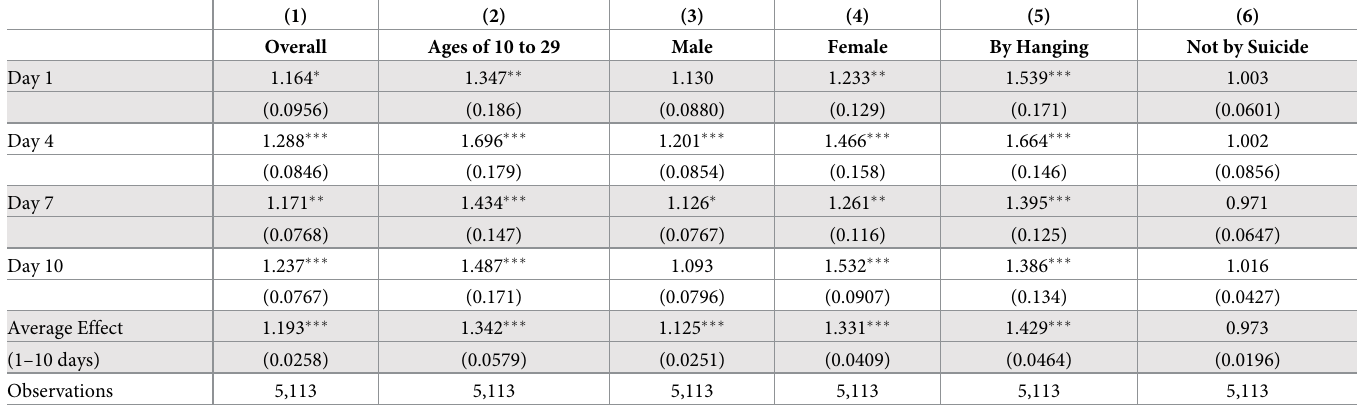
Table 3. Incident rate ratio (IRR) on days away from celebrity death incidents.